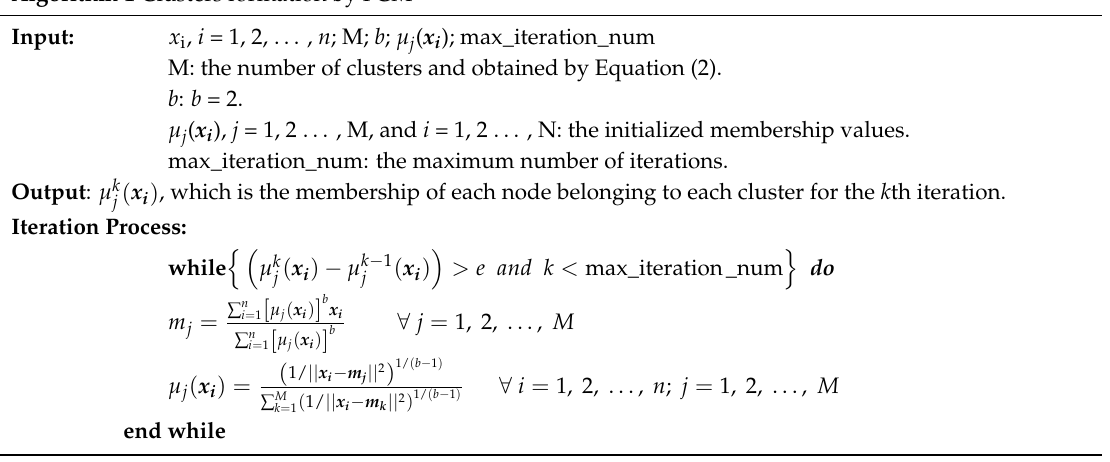
Algorithm 1 Clusters formation by FCM